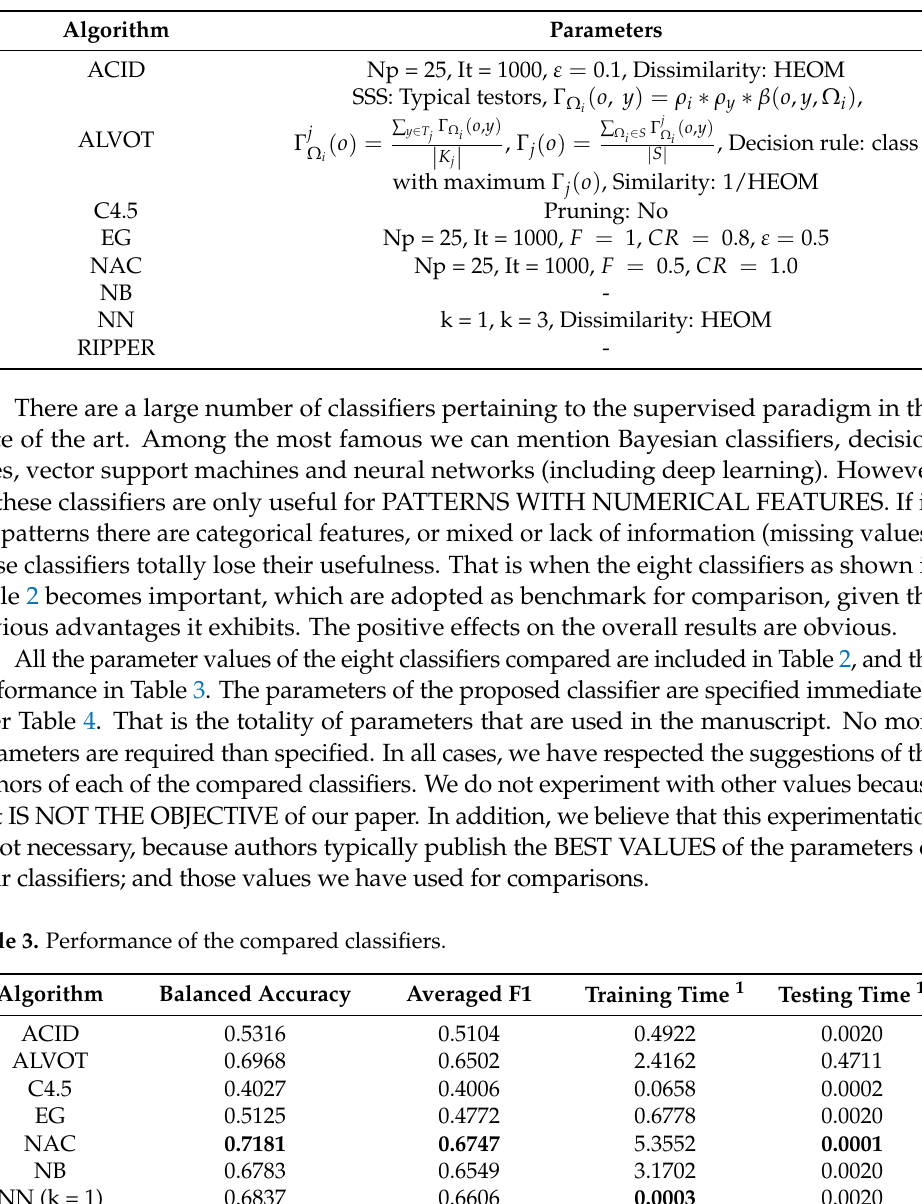
Table 2. Parameter values suggested by the authors of the compared classifiers.